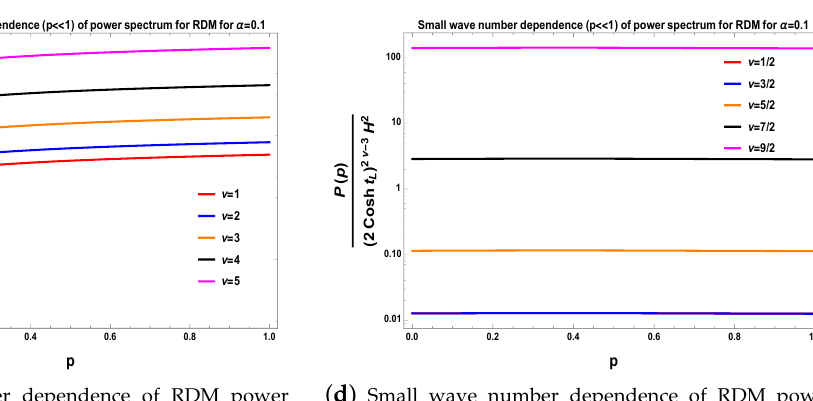
( a ) Small wave number dependence of RDM power spectrum for α = 0 and ν = 1,2,3,4,5.